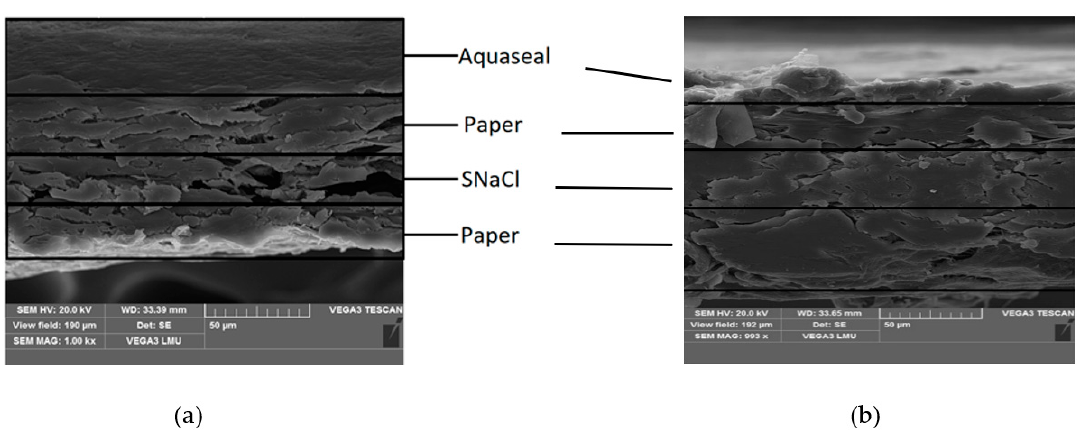
Figure 2. ( a ) Scanning electron microscope (SEM) image of the sandwich package before storage, ( b ) SEM image of the sandwich package after storage. ( b ) SEM image of the sandwich package after